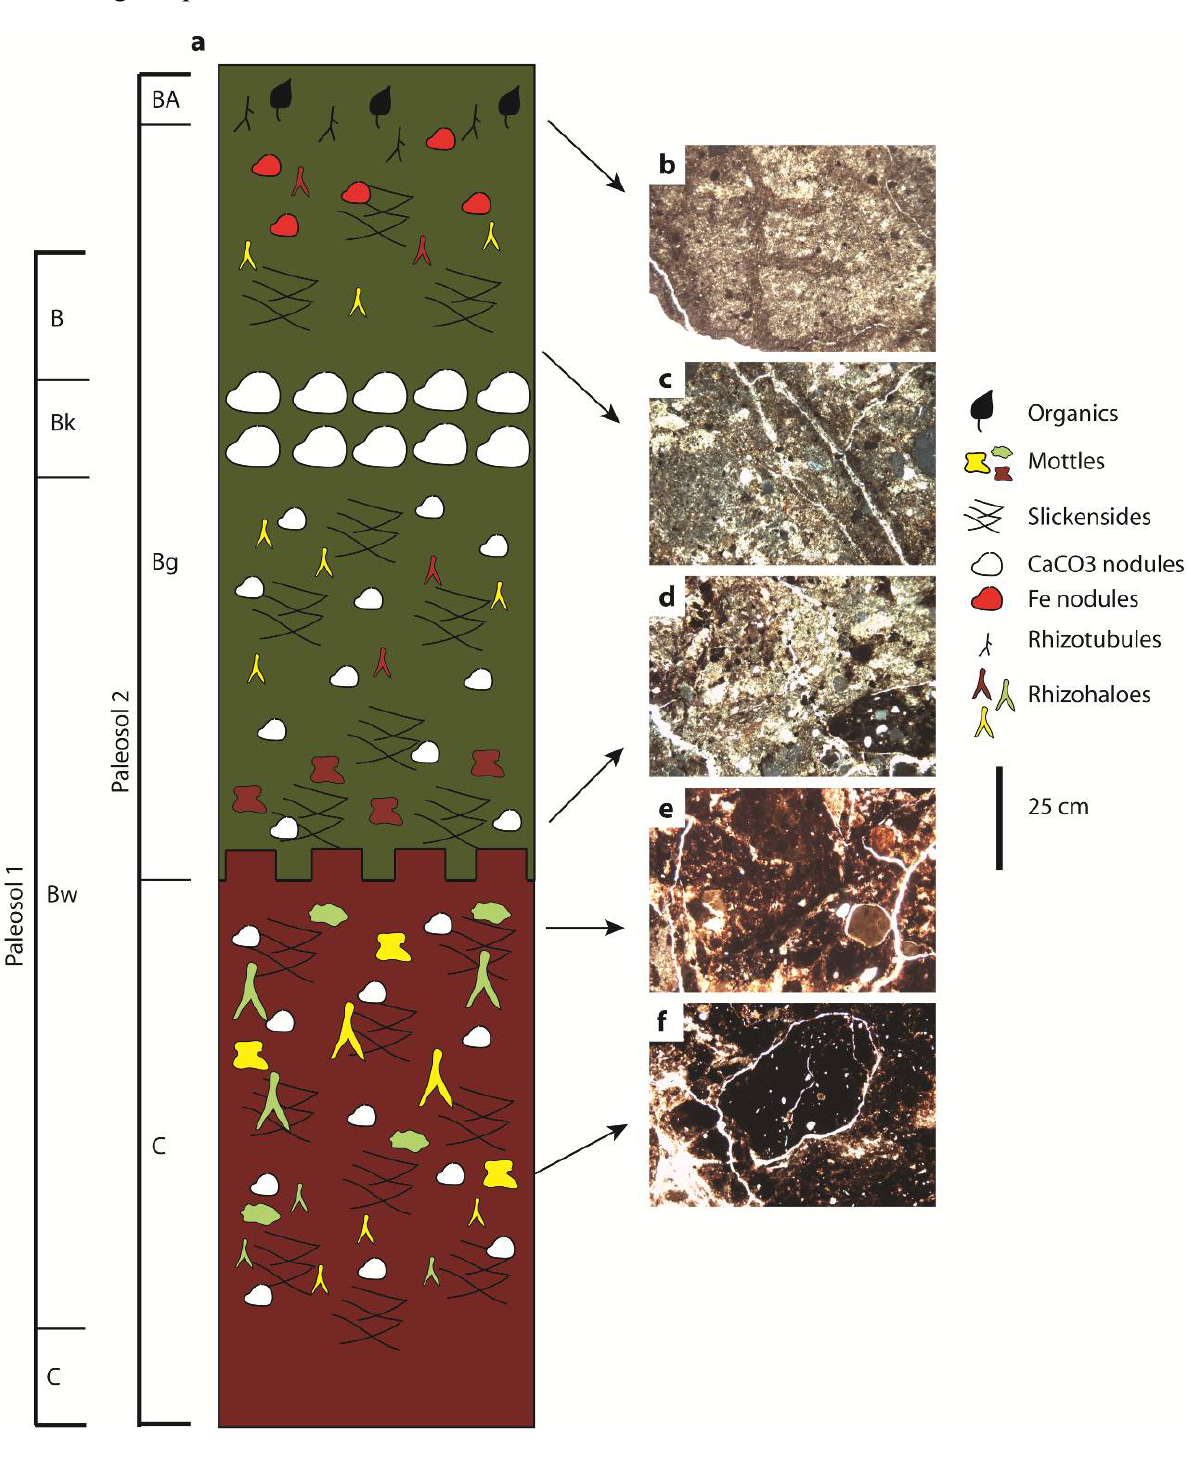
Figure 3. Detailed stratigraphic column and micromorphological features of the interpreted paleosols present in Section 1. ( a ) Detailed section of Units 1 and 2; ( b ) Root trace with a fine organic core, 20–40 cm; ( c ) Porphyroskelic fabric and fractures, 80–100 cm; ( d ) Fabric within gradational contact, 160–180 cm; ( e ) Rounded, clay aggregate, 200–220 cm; ( f ) Iron rich, subangular peds, 320–340